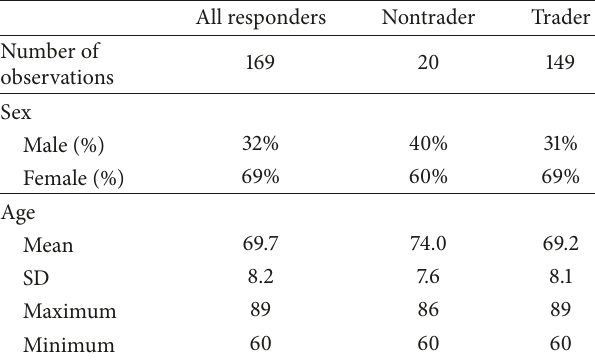
Table 4: Demographic information of